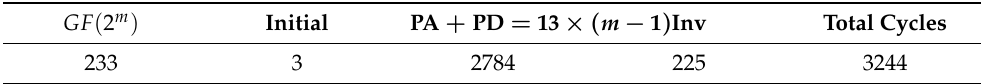
Table 3. Clock Cycles Informations.